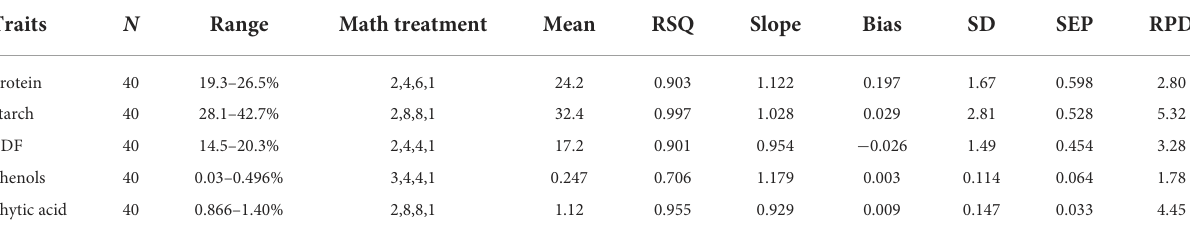
TABLE 3 External validation statistics of 40 cowpea